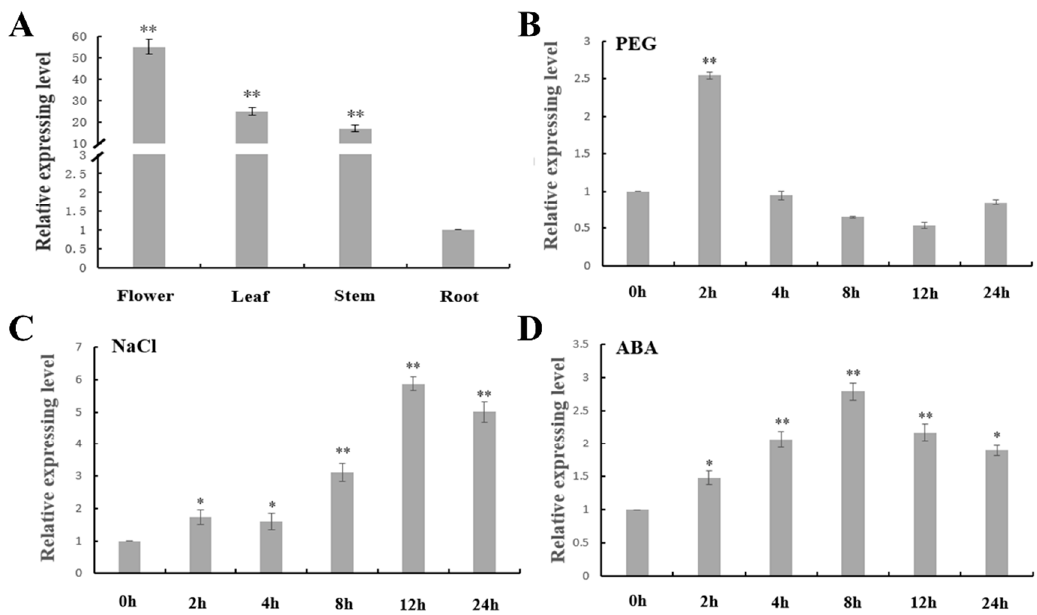
Figure 4. Expression profiles of MtNGA1 in M. truncatula . ( A ) Relative expression levels of MtNGA1 in different plant organs: the flowers, leaves, stems, and roots. ( B ) Relative expression levels of MtNGA1 under 15% Polyethylene Glycol (PEG) treatments. ( C ) Relative expression levels of MtNGA1 under 200 mM NaCl treatment. ( D ) Relative expression levels of MtNGA1 under 100 μ M ABA treatment. All samples were harvested at 0 h, 2 h, 4 h, 8 h, 12 h, and 24 h. The values are the means ± standard deviations (SDs; n = 3). * indicates significant differences of the means at p < 0.05 between flower, leaf or stem expression and root expression determined by expression analysis ( n = 3). ** indicates significant differences of the means at p < 0.01 between each treated sample and untreated sample determined by expression analysis ( n = 3).